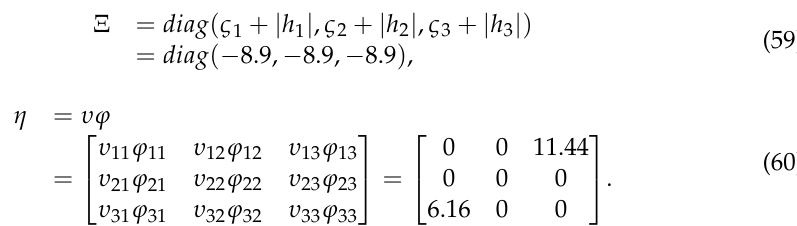
Figure 7. Time response sequence diagram of the three-dimension FOGRN when 0.5,0.8. α= .